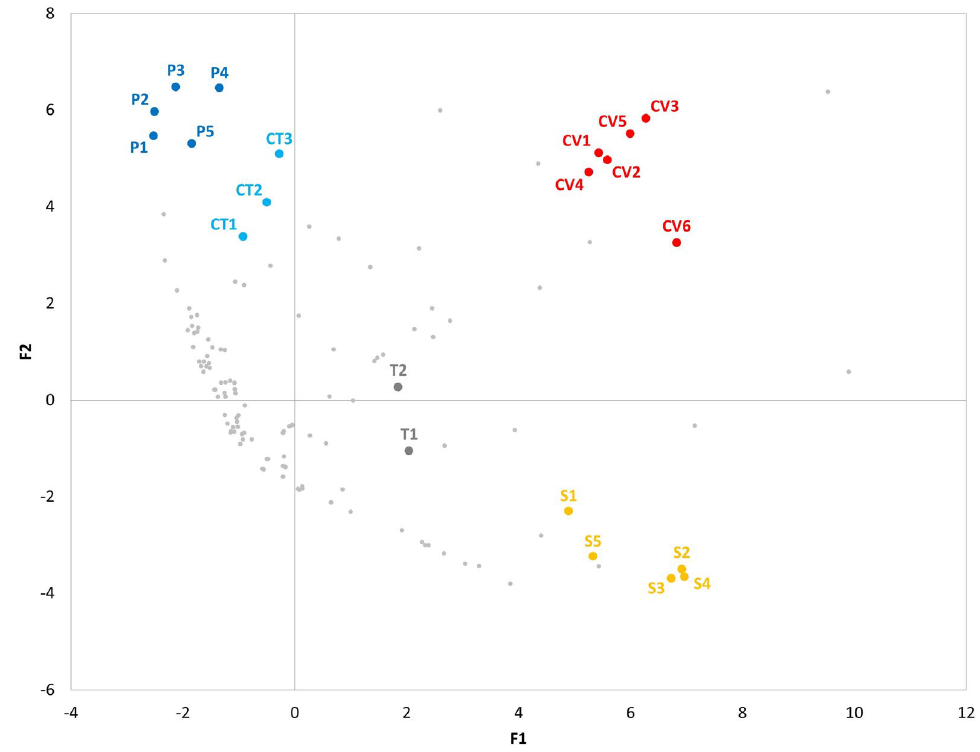
Figure 3. Dendrogram of the agglomerative hierarchical clustering of the vegetation relevés (T1–T2: Tuscany; S1–S5: Sicily; CV1–CV6: Campania–Mt. Vesuvius; CT1–CT3: Campania–Tifatini Mts.; P1– P5: Apulia).